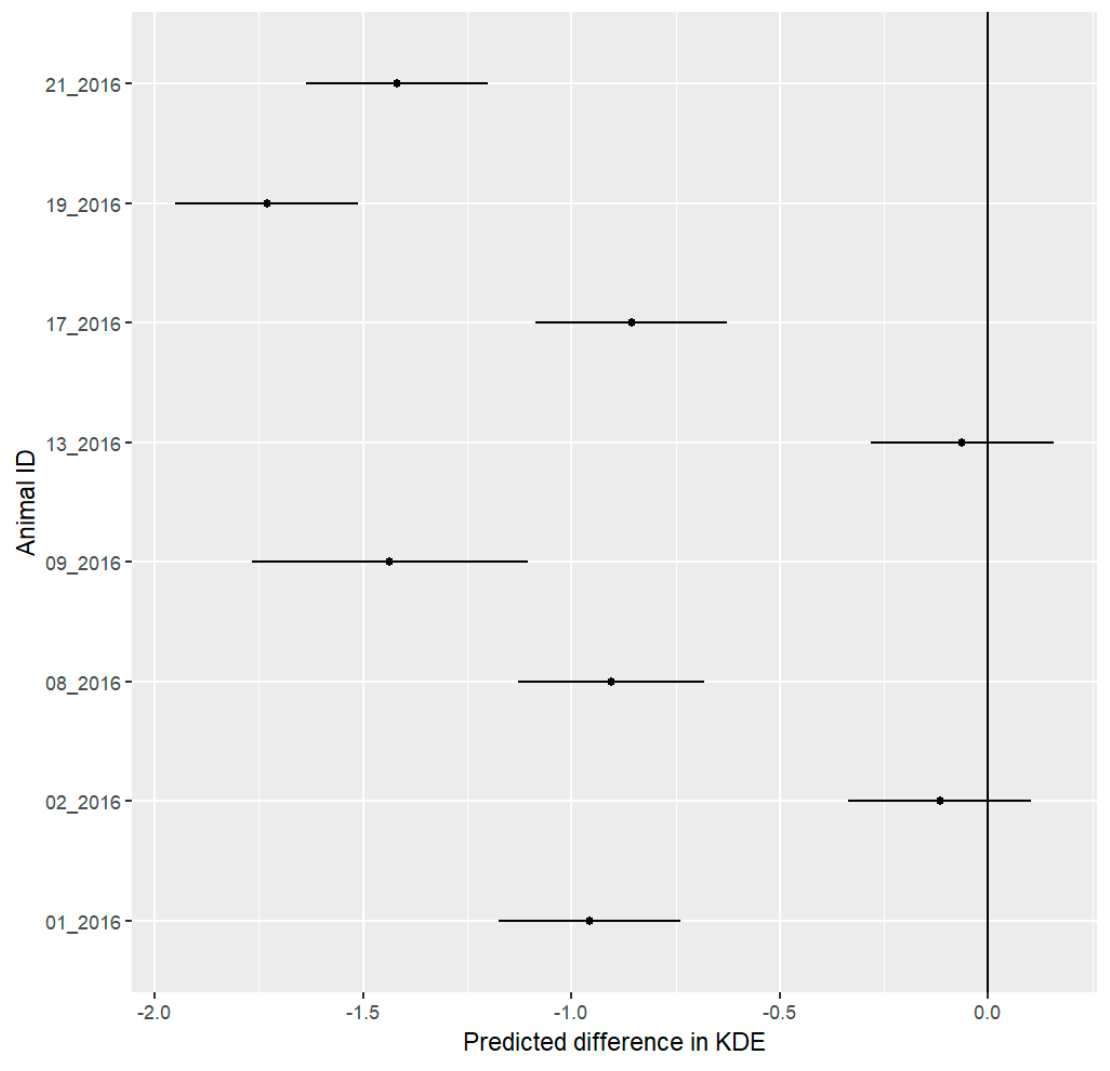
Figure 1. Mean predicted differences with 95% confidence interval for differences in daily Kernel density estimation 50% (50KDE) areas of eight hedgehogs between the pre-festival and festival phases. The predicted difference represents changes in hectares. We consider all differences to be significant where the confidence interval does not include 0. Six out of eight hedgehogs show a significant decrease in KDE50.